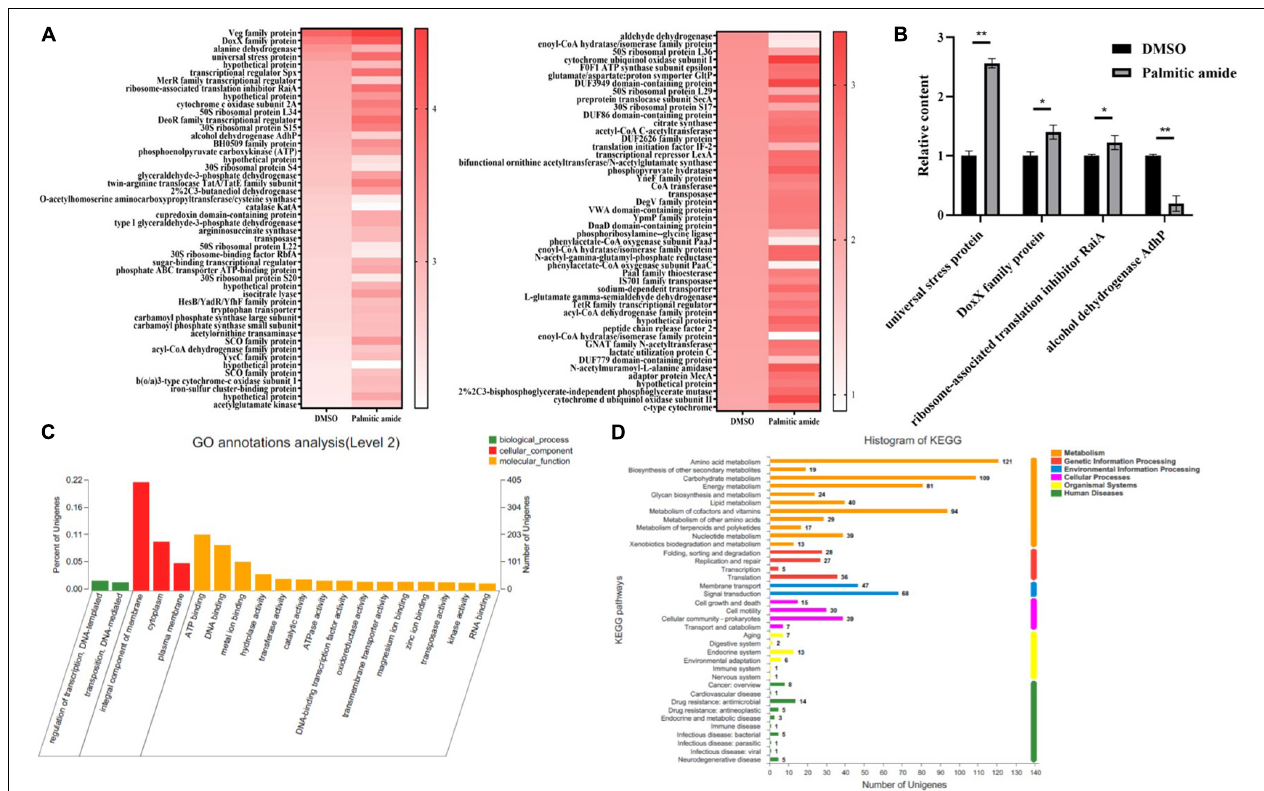
FIGURE 3 | Pathways mediated by palmitic amide packaged in viral particles. (A) Heat map of the differentially expressed genes in Geobacillus sp. E263 treated with palmitic amide or DMSO. Geobacillus sp. E263 was added with palmitic amide or DMSO and then cultured for 24 h. Subsequently the mRNAs of Geobacillus sp. E263 were subjected to sequencing. (B) Confirmation of the differentially expressed genes. Geobacillus sp. E263 was treated with DMSO or palmitic amide, followed by examination with quantitative real-time PCR. Four genes were randomly selected for this analysis. The statistical significance of difference between treatments was indicated with asterisks (* p < 0.05; ** p < 0.01). (C) GO analysis of differentially expressed genes between Geobacillus sp. E263 treated with palmitic amide and DMSO. (D) KEGG analysis of differentially expressed genes between Geobacillus sp. E263 trated with palmitic amide and